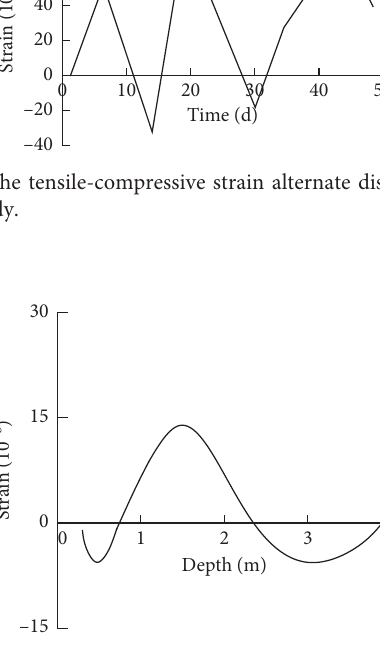
Figure 6: Measured in situ results of tensile-compressive strains distributed periodically in surrounding rock.